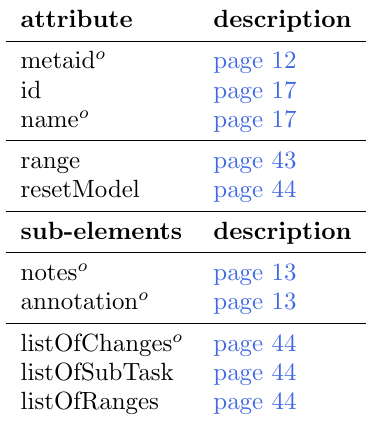
Table 2.20: Attributes and nested elements for repeatedTask. o denotes optional elements and at-